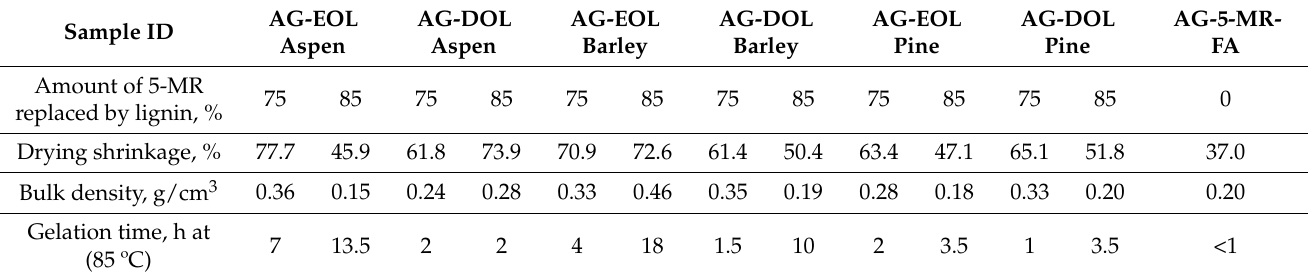
Table 3. The drying shrinkage, bulk density, and gelation time of lignin- based and 5-MR-FA aerogels.